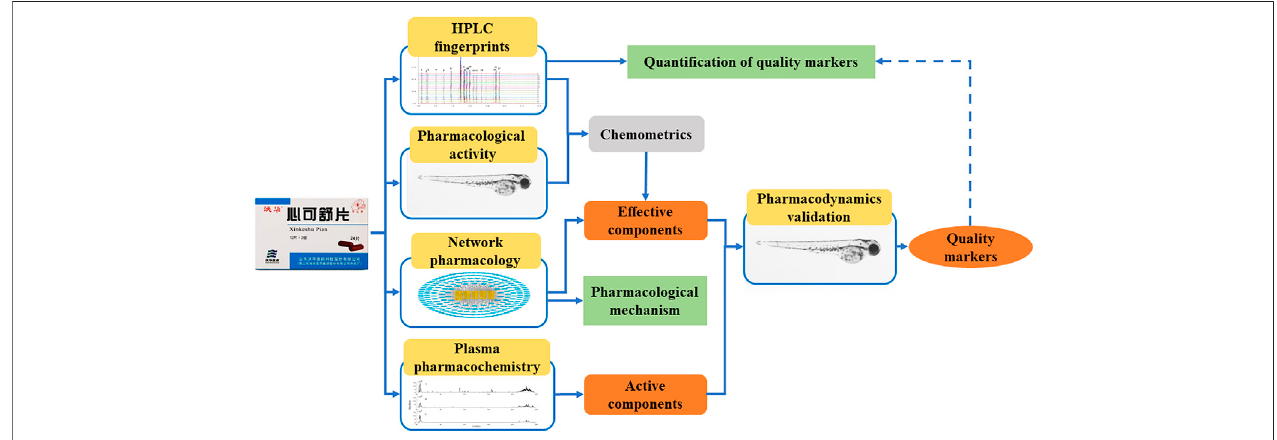
FIGURE 1 | Strategy to identify and quantify quality markers of